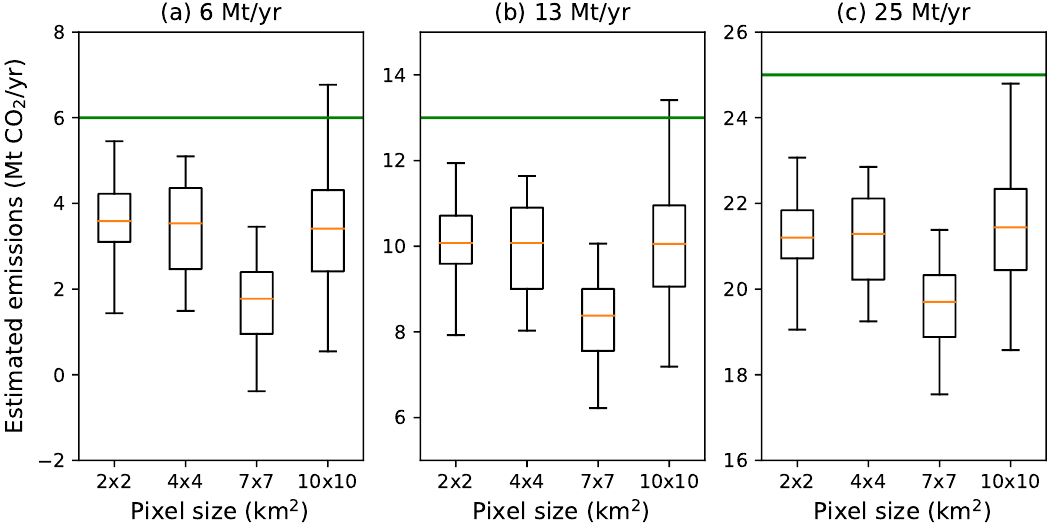
Figure 7. Emission rate estimates for all 12 combinations of pixel sizes and emission rates for an ensemble of 30 simulations as in Figure 5, with topography, footprint, albedo, and stability class